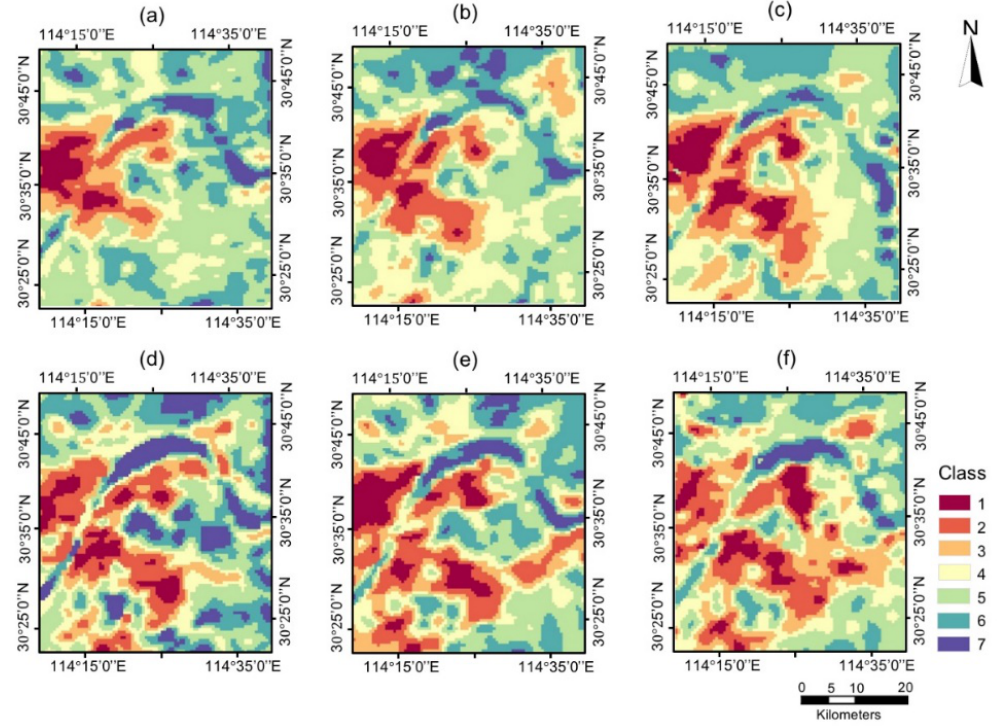
Figure 9. The spatial classification results of the 6 years. ( a ) 2002; ( b ) 2005; ( c ) 2008; ( d ) 2011; ( e ) 2014; ( f ) 2017.